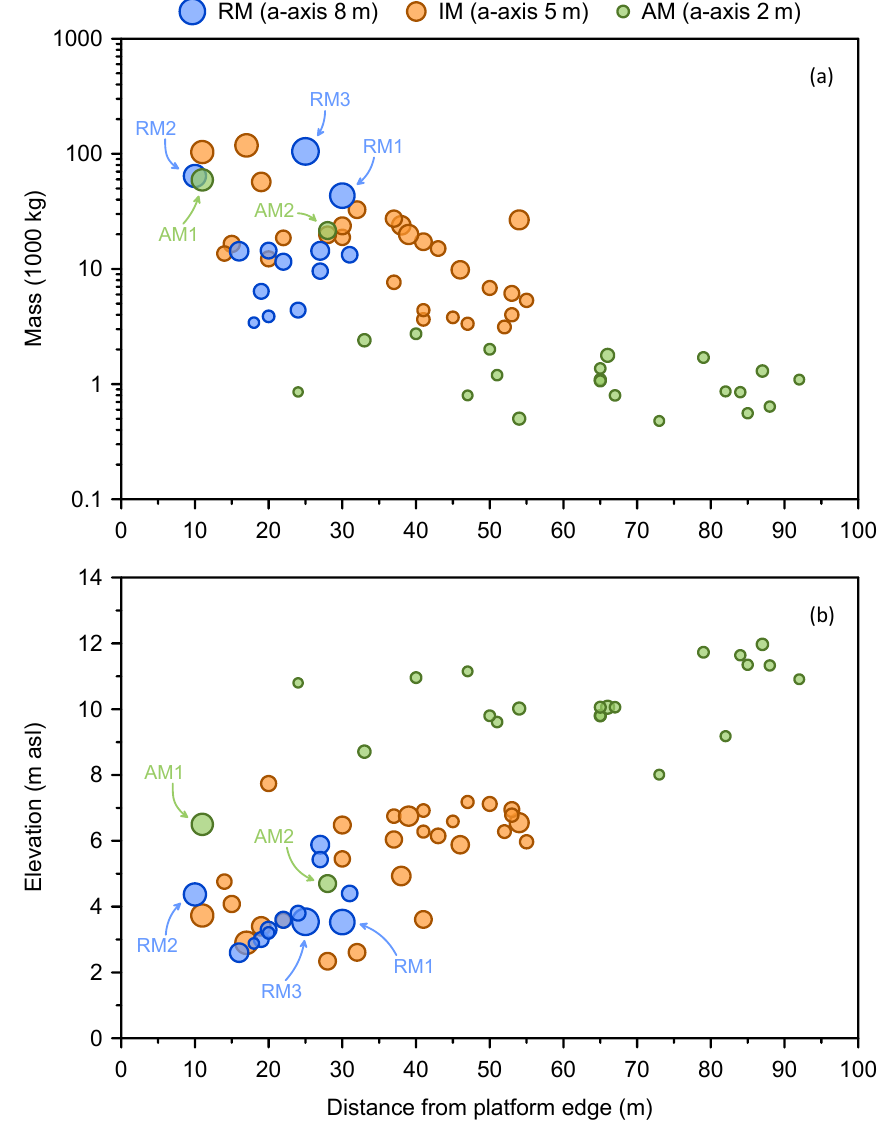
Figure 8. Distribution of the boulders of interest, illustrating the relationships between distance from the shoreline and: ( a ) boulder mass, and; ( b ) ground elevation. The boulders of interest are separated into recent movers (RM), indeterminate movers (IM) and ancient movers (AM), enabling comparison between boulder size (a-axis shown by symbol size); prominent labelled boulders are discussed in the